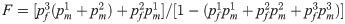
Relation between index of female educational advantage (F) and shares of hypergamic, homogamic, and hypogamic married couples.The selected countries are Belgium, Denmark, Finland, France, Germany, Greece, Ireland, The Netherlands, Portugal, Spain, Sweden, and United Kingdom. The selection is based on the data available for initializing the simulation model and for validating simulation outcomes. The figure shows for each country the four birth cohorts 1950 = (1940–1950], 1960 = (1950–1960], 1970 = (1960–1970], and 1980 = (1970–1980]. Data for calculating the index of female educational advantage F [3] come from the population reconstructions/projections by age, sex, and level of educational provided by the International Institute for Applied Systems Analysis/Vienna Institute for Demography, based on the age categories 30 to 34 and 35 to 39 years in 1980, 1990, 2000, and 2010. We used the global educational trend scenario for projections in 2010. The index is calculated as F=[pf3(pm1+pm2)+pf2pm1]/[1−(pf1pm1+pf2pm2+pf3pm3)], where pfs and pms refer to the shares of women (f) and men (m) in the ordered educational categories (s) 1 = ‘no education’/ ‘primary education’, 2 = ‘secondary education’, and 3 = ‘tertiary education’. The index equals 0 when every woman in the population holds a lower educational degree than any randomly selected man, 0.5 when men and women are equally educated, and 1 when every woman in the populations holds a higher educational degree than any randomly selected man. Data for calculating the shares of different types of married couples come from rounds 5 and 6 the European Social Survey. Weighting has been applied. Black lines are simple regression slopes fitted to the data.